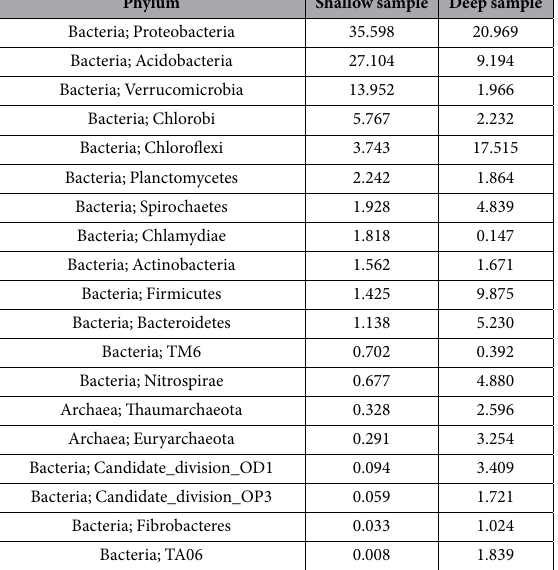
Table 2. Prokaryotic OTUs percent abundance distribution at phylum level. The superkingdom (bacteria or Archaea) is indicated, followed by the Phylum denomination. Taxa whose presence in at least one of the two samples was > 1% are shown. Frequencies are ordered in decreasing abundance of the shallow sample